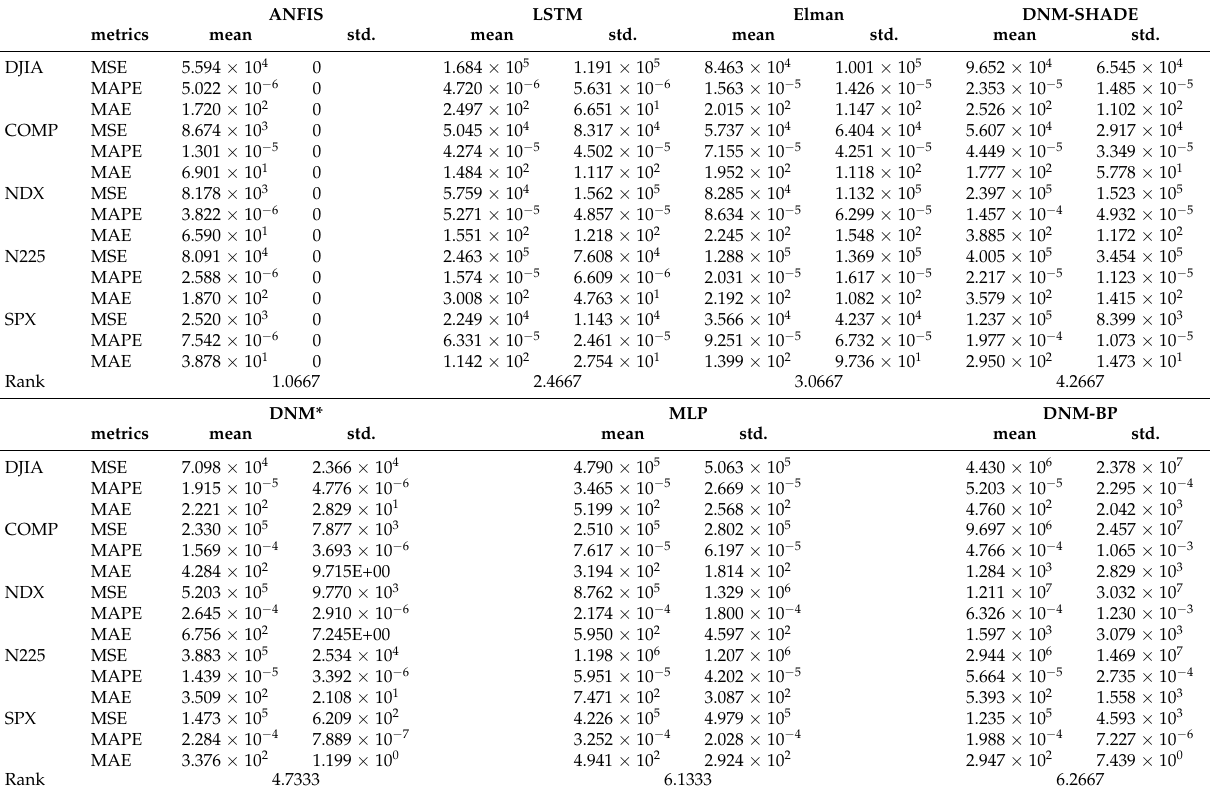
Table 5. Performance of various types of time-series-forecasting